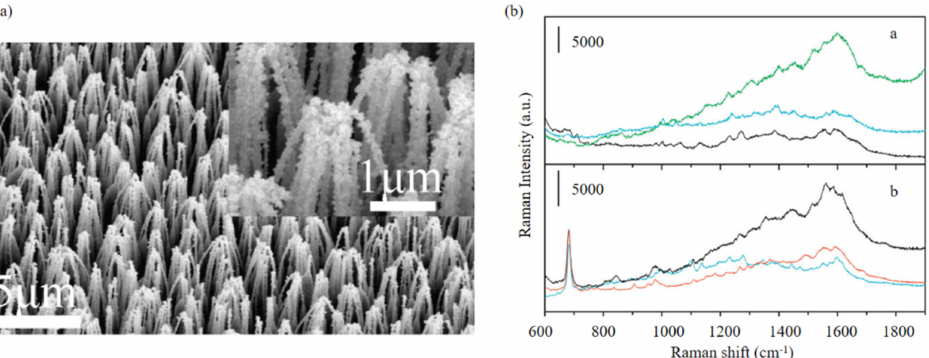
Figure 6. ( a ) SEM image of ZnO/Au composite nanoneedle arrays; ( b ) SERS spectra of egg white solution (6 g/L) ( a ) and the melamine-tainted egg white solution ( b ) on ZnO/Au nanoneedles. The concentration of melamine and egg white in the mixture is 1.0 × 10 − 5 M and about 6 g/L, by Chen et al.